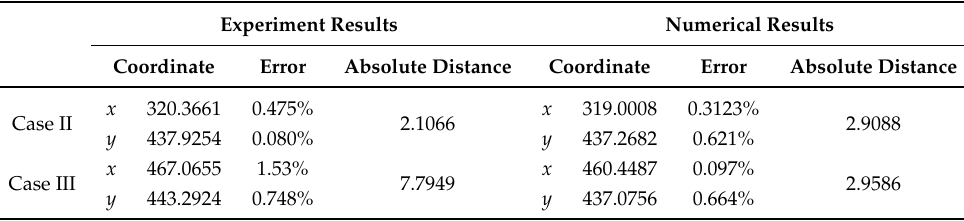
Table 12. Experimental and simulation results of two groups of 4 sensors under Case II and Case III. Experiment Results Numerical